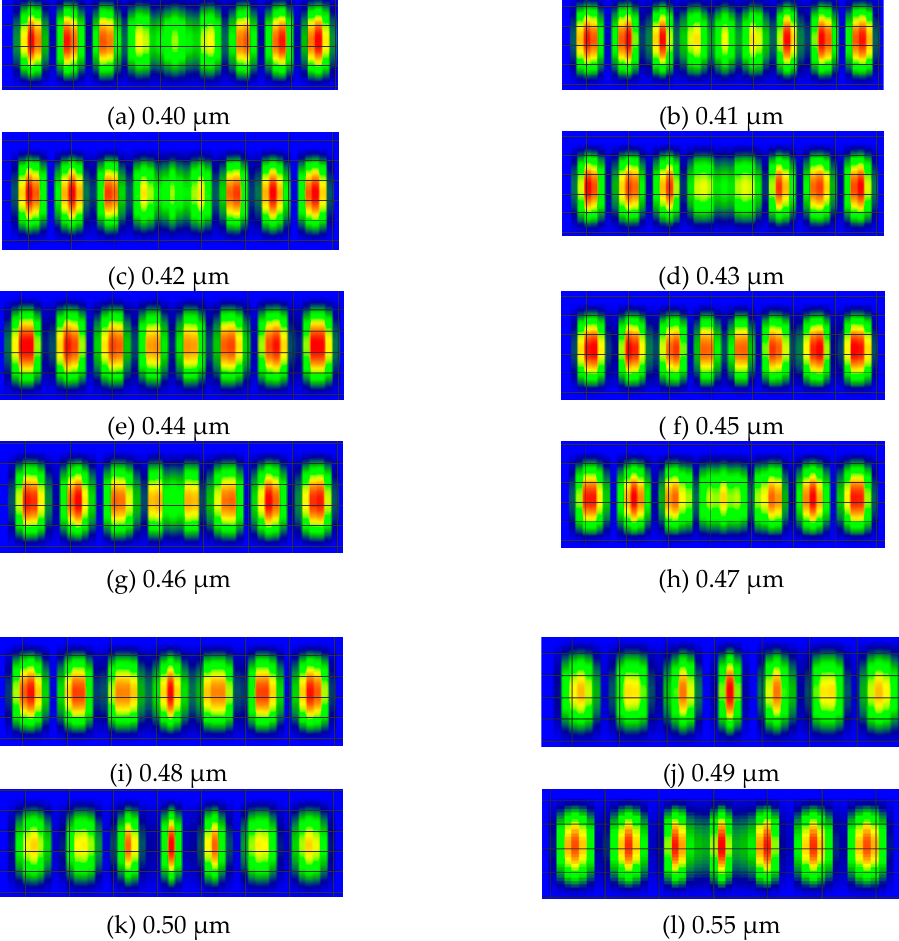
Figure 9. The optical field profiles at the output ports for various wavelengths close to the operating wavelength.